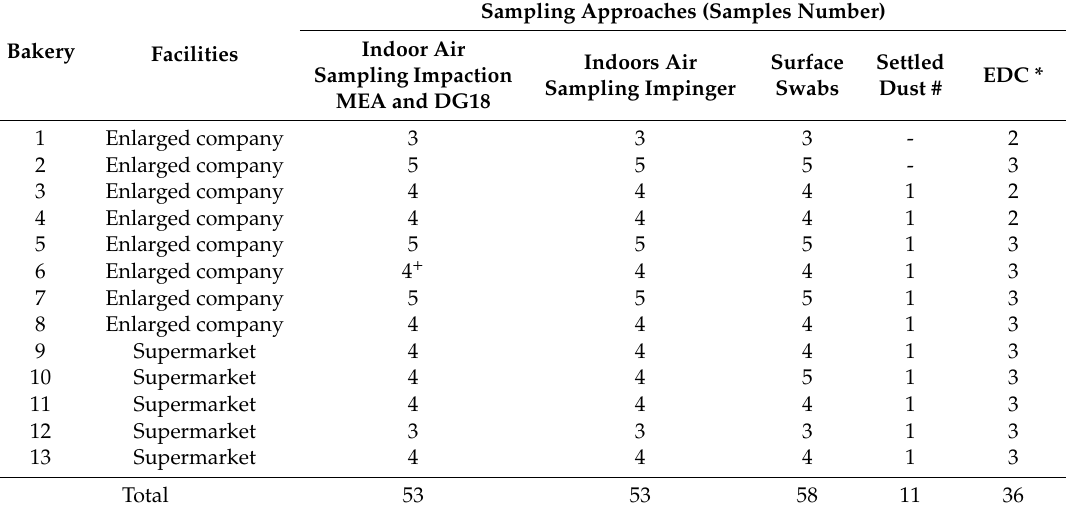
Table 1. Environmental and raw material samples distributed for each bakery assessed for mycobiota